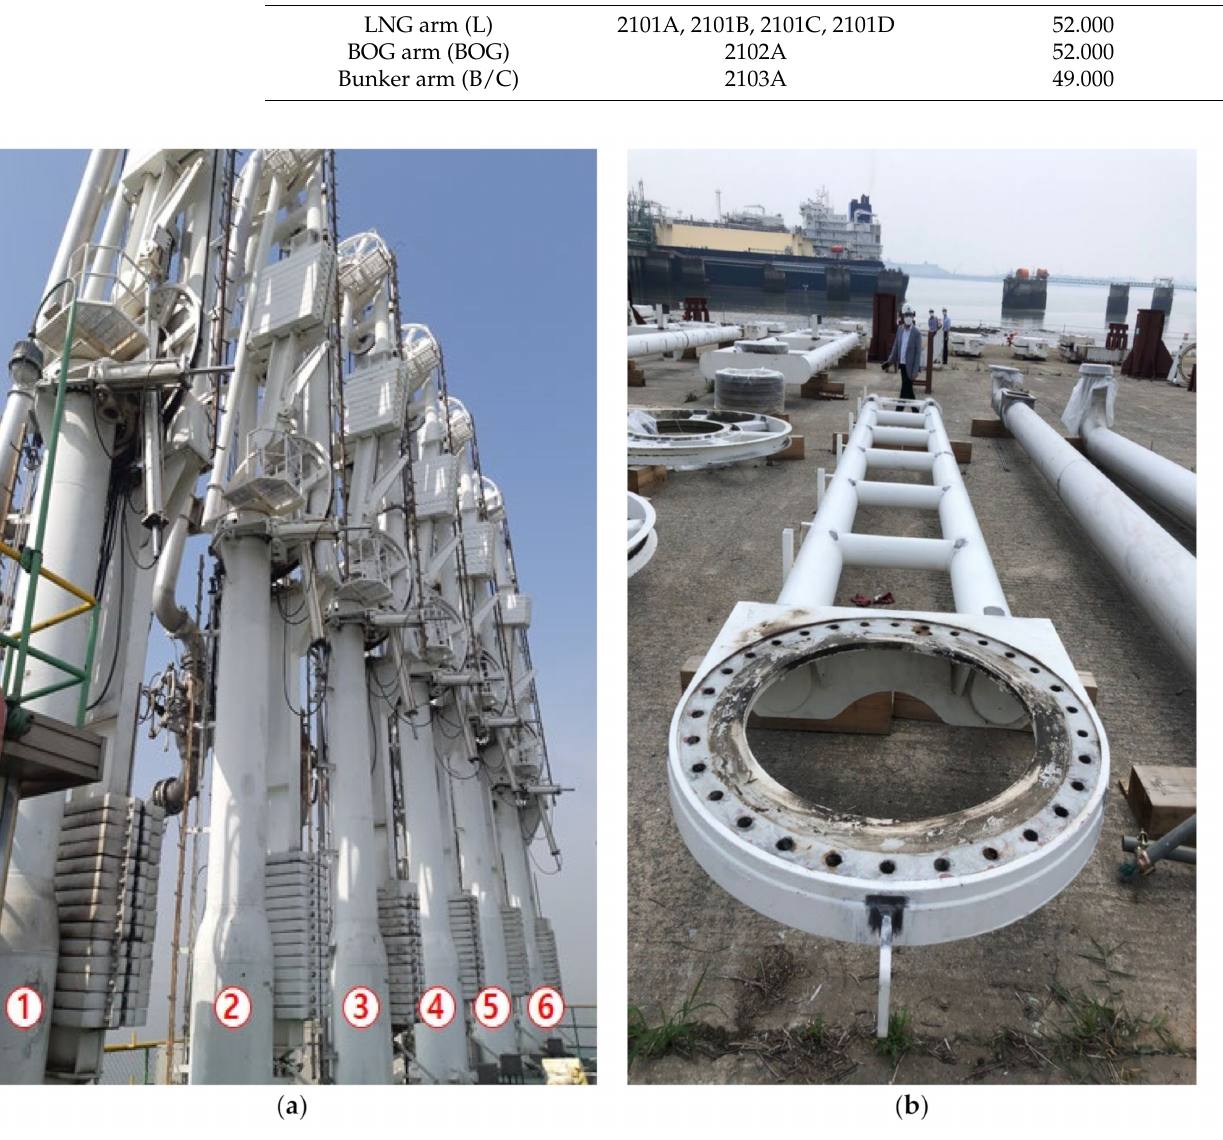
Figure 3. ( a ) Six models of the ULA system located at the “A” LNG terminal and ( b ) image of disassembling ULA components during a major